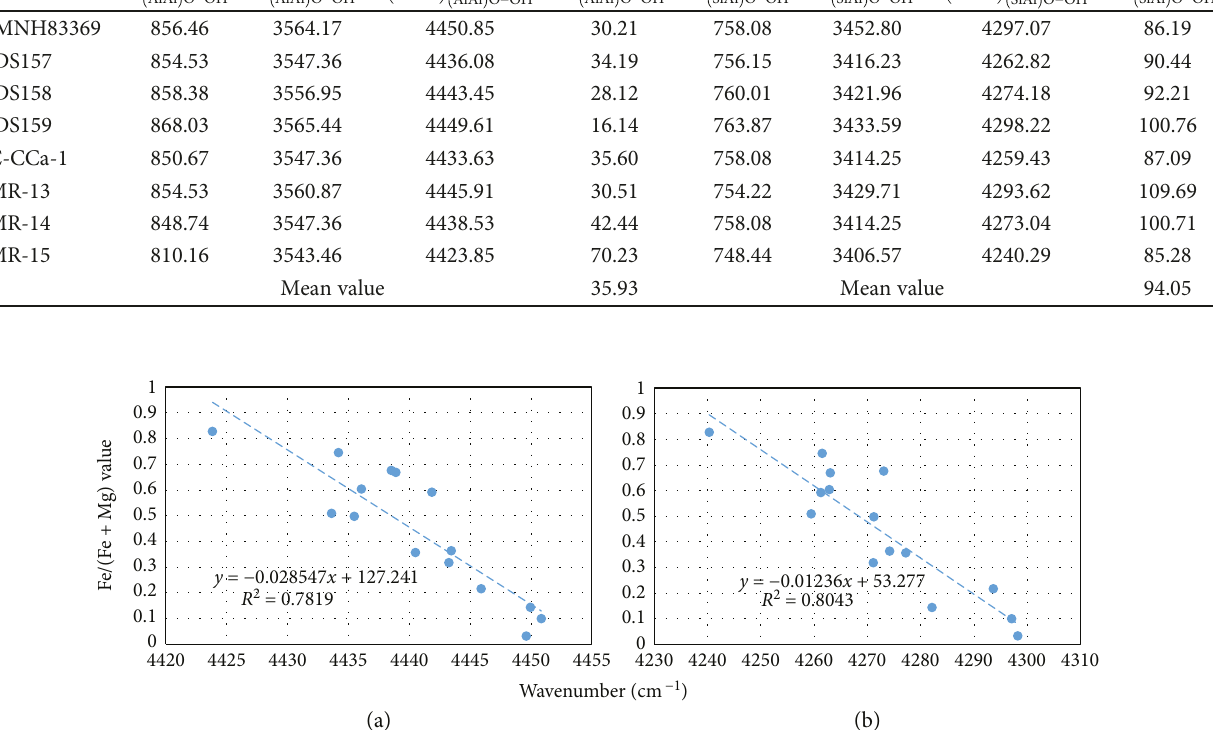
Figure 8: Linear relationships between diagnostic NIR bands ((a) shows the band near 4440 cm − 1 , and (b) shows the band near 4270cm − 1 ) and Fe/(Fe+ Mg) value.